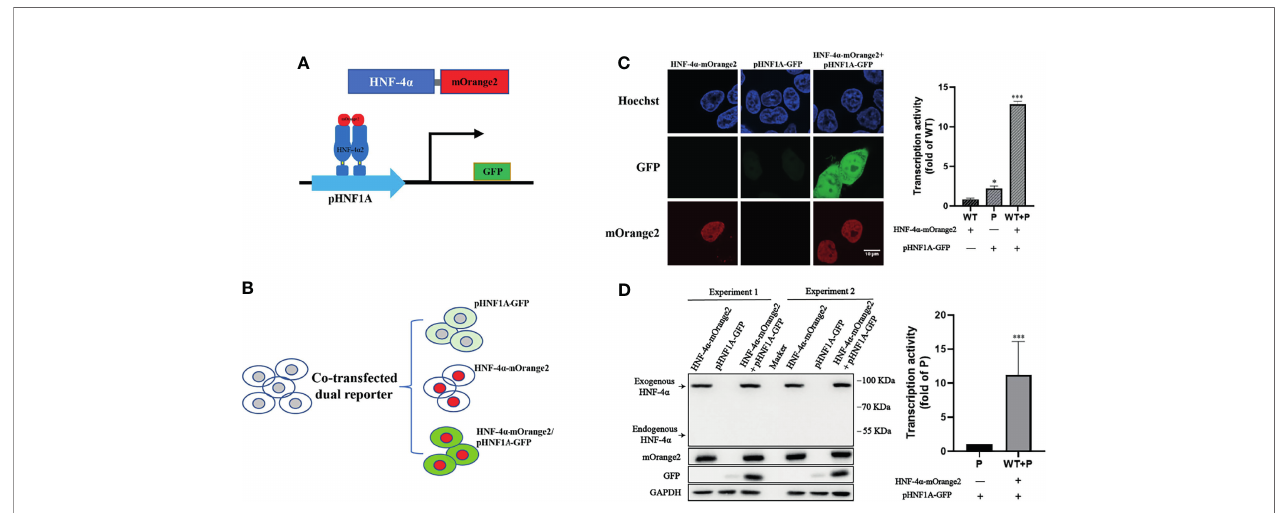
FIGURE 1 | Establishment of the dual- fl uorescence assay for functional evaluation on the HNF-4 a . (A) A schematic diagram of the dual- fl uorescence reporter system. The C-terminal of HNF-4 a was fused with a red fl uorescent protein mOrange2 and was used to track the HNF-4 a cell location and expression; pHNF1A was the GFP reporter under control of the HNF-1 a promoter which was used to detect the transcription activity of the HNF-4 a dimer. (B) Overview of the assay working in cell lines. (C) Representative confocal microscopy imaging of dual- fl uorescence assay and quanti fi cation of the transcription activity. Nuclear staining (blue); 488-nm channel for pHNF1A-GFP (green); 561-nm channel for HNF-4 a -mOrange2 (red). The GFP intensity of the three groups has also been quanti fi ed with three fi elds in one experiment; the data were analyzed using a Student t-test (*p < 0.05, ***p < 0.001). WT, wild-type HNF-4 a -mOrange2, P, pHNF1A-GFP. (D) Representative Western blots and quanti fi cation of GFP intensity of cells transfected with plasmids as indicated for 48 h. The anti-mCherry antibody and anti-HNF-4 a antibody were used for detection of mOrange2-conjugated HNF-4 a proteins and HNF-4 a proteins, respectively. The anti-GAPDH antibody was the internal reference in this experiment. The anti-GFP antibody showed the transcription activity. Data represented as mean± SD from six independent